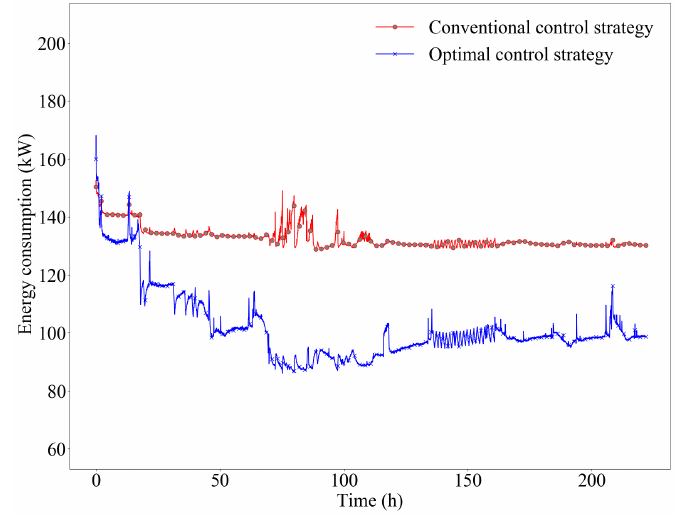
Figure 12. Comparison of energy